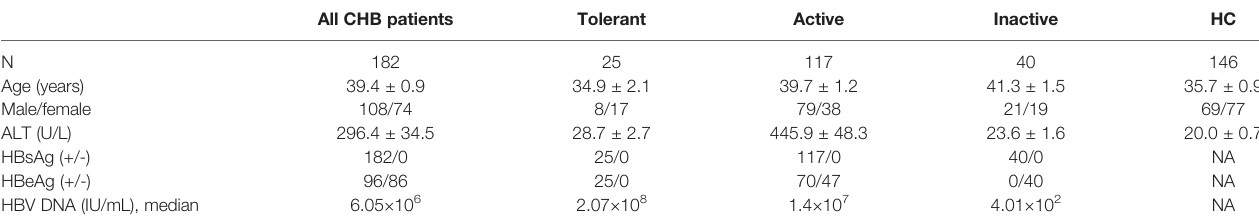
TABLE 1 | Characteristics of human